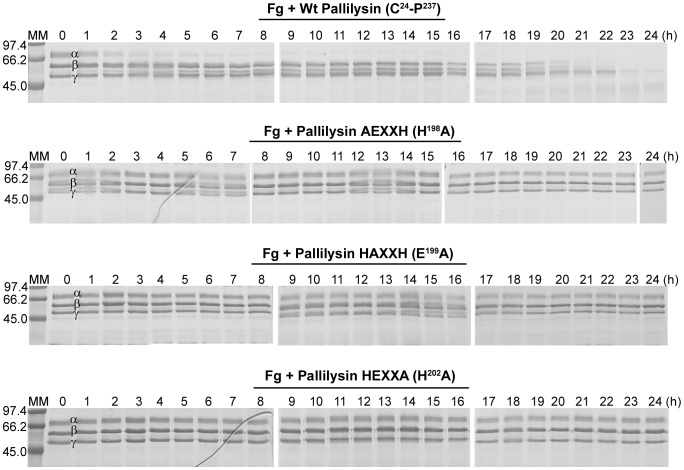
Site-directed mutagenesis of the pallilysin HEXXH histidine and glutamic acid residues abolishes fibrinogenolytic activity.Recombinant wild-type pallilysin (C24-P237) and the three pallilysin mutants (AEXXH [H198A], HAXXH [E199A], and HEXXA [H202A]) (300 µg) were incubated with plasminogen-free human fibrinogen (600 µg) at 37°C for 24 h. Samples were removed every hour from 0–24 h post-incubation and analyzed by SDS-PAGE for degradation of the fibrinogen α-, β-, and γ-chains. Negative controls included fibrinogen incubated alone (Fg only) and fibrinogen incubated in the presence of Tp0453 (data not shown). Each lane contains approximately 6 µg of protein. Numbers to the left of the lanes indicate the size (kDa) of the corresponding molecular mass (MM) markers.